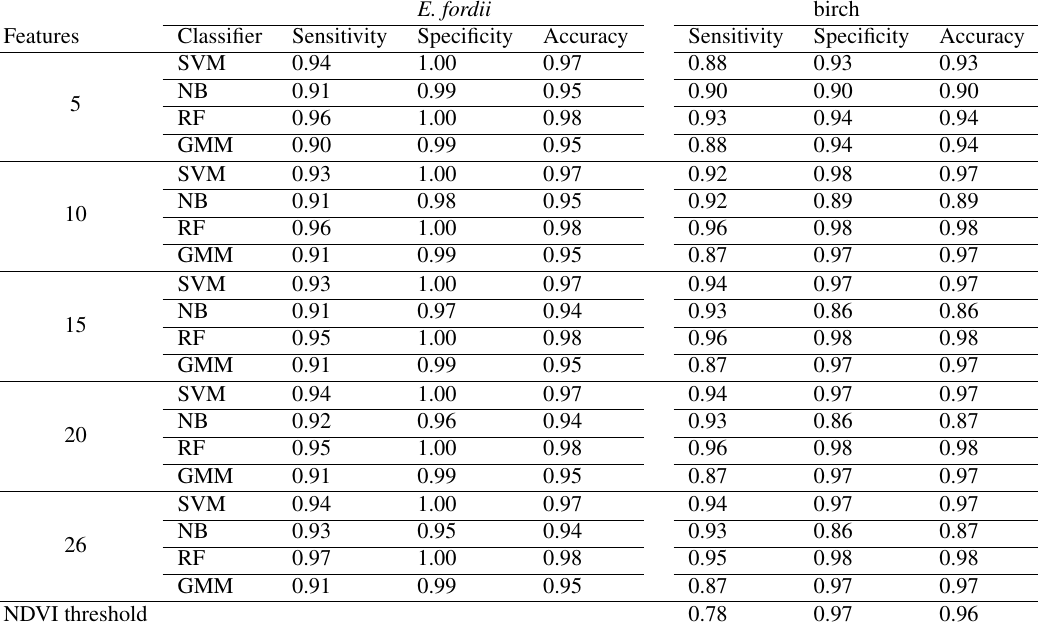
Table 2. Statistical evaluation of machine learning classifiers for wood-leaf